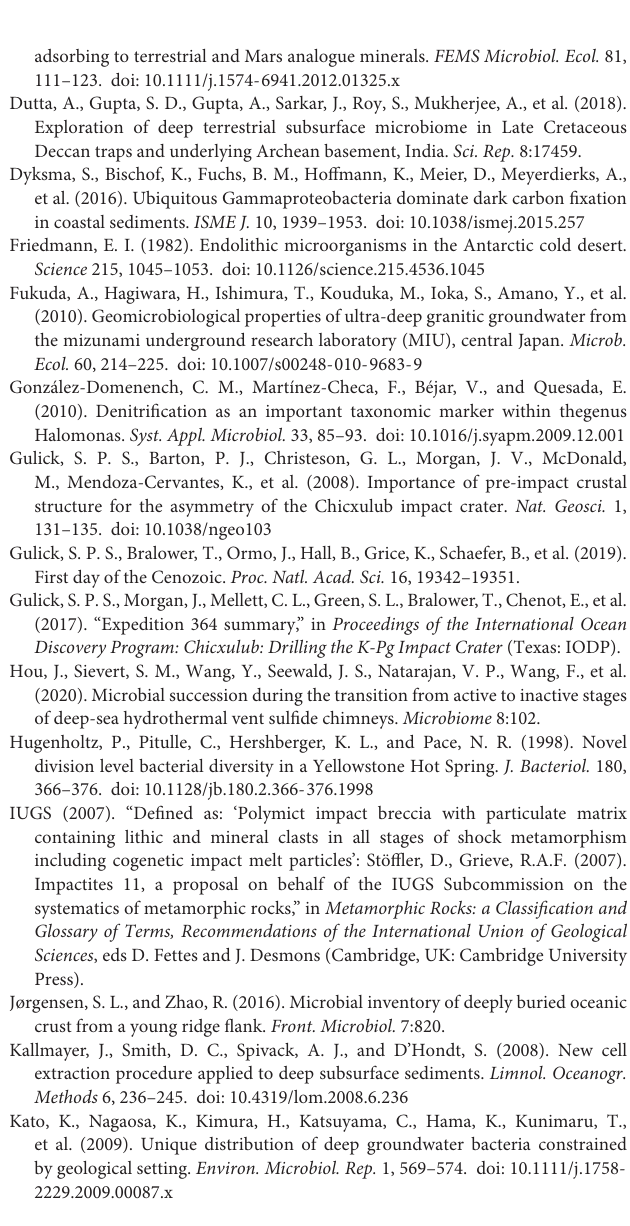
Supplementary Figure 1 | Downcore distributions of (A) S, (B) Fe, (C) Mn (wt%), and (D) temperature ( ◦ C). Supplementary Figure 2 | Cell enumerations in drilling mud mix. Supplementary Figure 3 | Canonical analysis of principal coordinates (CAP) showing the spatial distribution of all 2,757 ASVs that were recovered from the core samples as well as from the various controls for contamination. Supplementary Figure 4 | Bar graph showing the relative abundance of the major phyla in samples from the three lithologies and in the corresponding drilling muds. Supplementary Figure 5 | Abundances of microbial taxa. Supplementary Figure 6 | Relative abundance of ASVs at phylum (% of total phyla) and class (% of the corresponding phylum) levels. Supplementary Table 1 | Lithology associated with the sampled core depths.